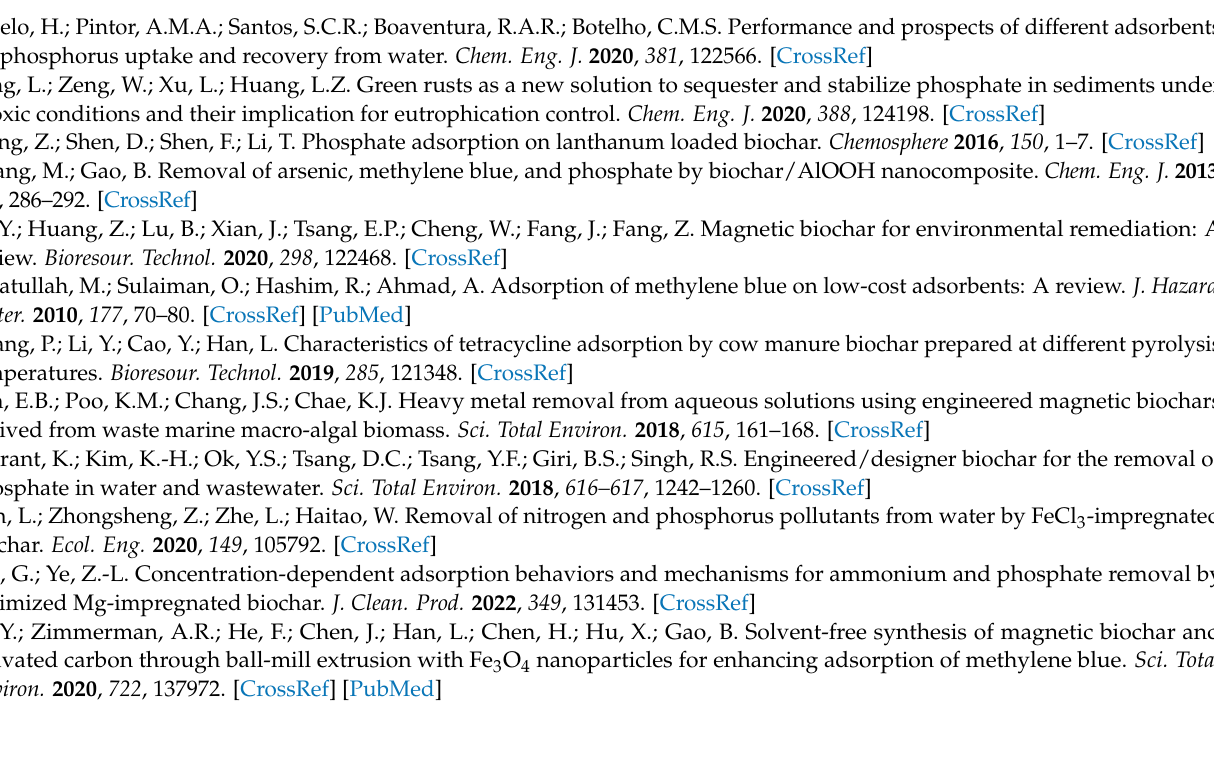
alginate gel reaction. Figure S2: Color comparison of phosphate solution before and after adsorption after the chromogenic reaction. Figure S3: (a) FT-IR and (b) XRD spectra of MgBC with different mass ratios of MgCl 2 · 6H 2 O and biochar. Figure S4: SEM images of different mass ratios of MgCl 2 · 6H 2 O and biochar (a) 0, (b) 0.75, (c) 1.25, and (d) 1.5. Figure S5: XRD spectra of MgBC at different ball- milling times. Figure S6: (a) XRD and (b) FT-IR spectra of MgBC at different pyrolysis temperatures. Figure S7: SEM images of adding 2.5 g MgCl 2 · 6H 2 O MgBC pyrolyzed at (a) 550 ◦ C and (b) 650 ◦ C. Figure S8. N 2 adsorption–desorption isotherms and pore size distribution of MgBC under optimal preparation conditions. Figure S9: EDS results of SA-MgBC-3 and FeSA-MgBC-3. Table S1: EDS results of SA-MgBC-3 and